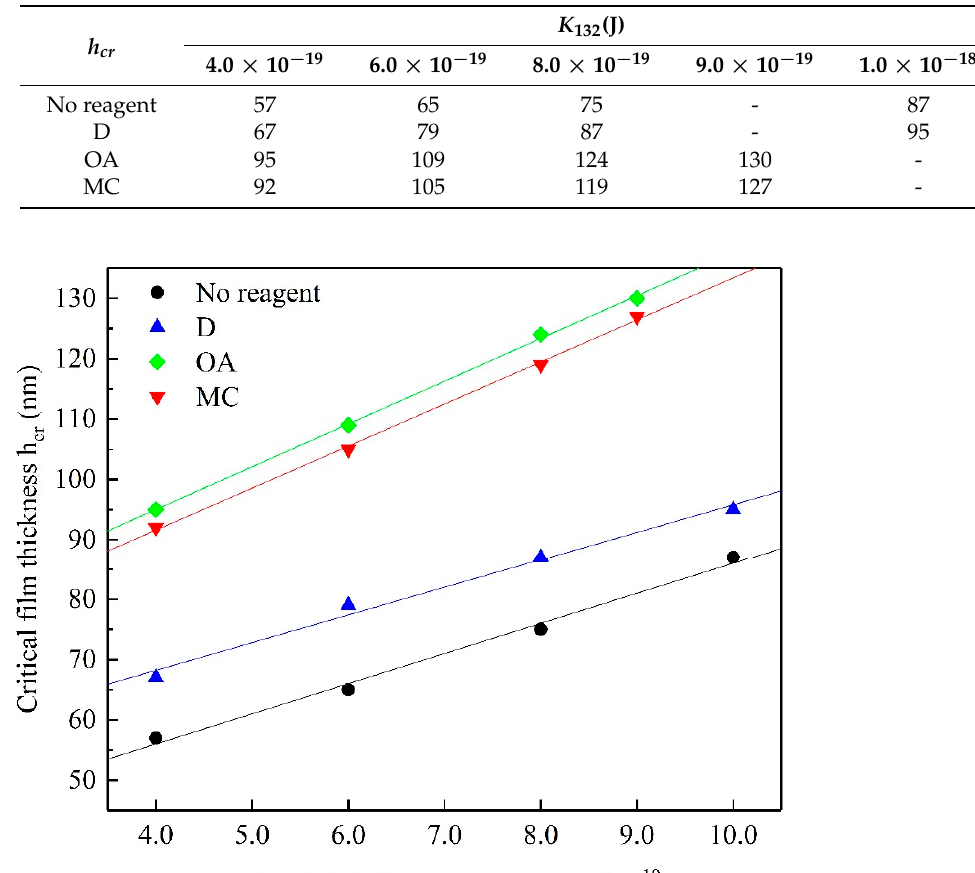
Table 3. The hydrophobic constant and the corresponding wetting film thickness of coal treated with different reagent.